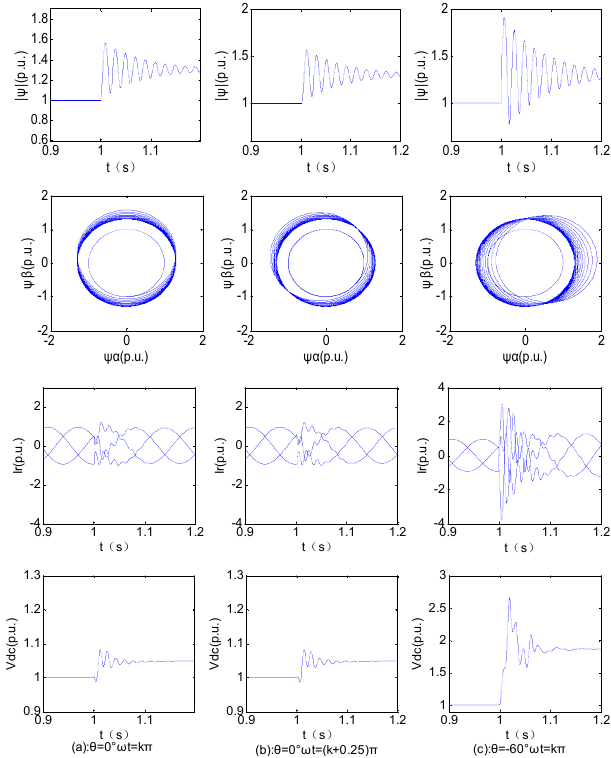
Figure 5. Simulation results for three-phase faults (1.3 p.u.) with different voltage phases when faults and phase-angel jump occur ( a ) phase angel jump θ = 0°, ω t = k π ; ( b ) phase angel jump θ = 0°, ω t = ( k + 0.25) π ; and ( c ) phase angel jump θ = 60°, ω t = k π .